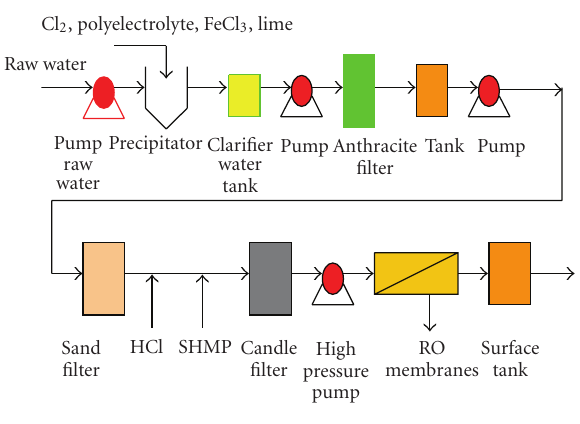
Figure 1: Flow Diagram of RO